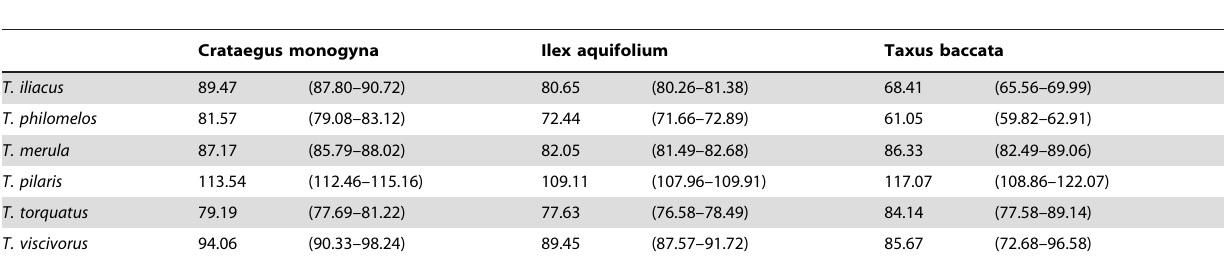
Table 2. Mean dispersal distances produced by each Turdus species varied among fleshy-fruited plant species reflecting landscape effects on bird behaviour.